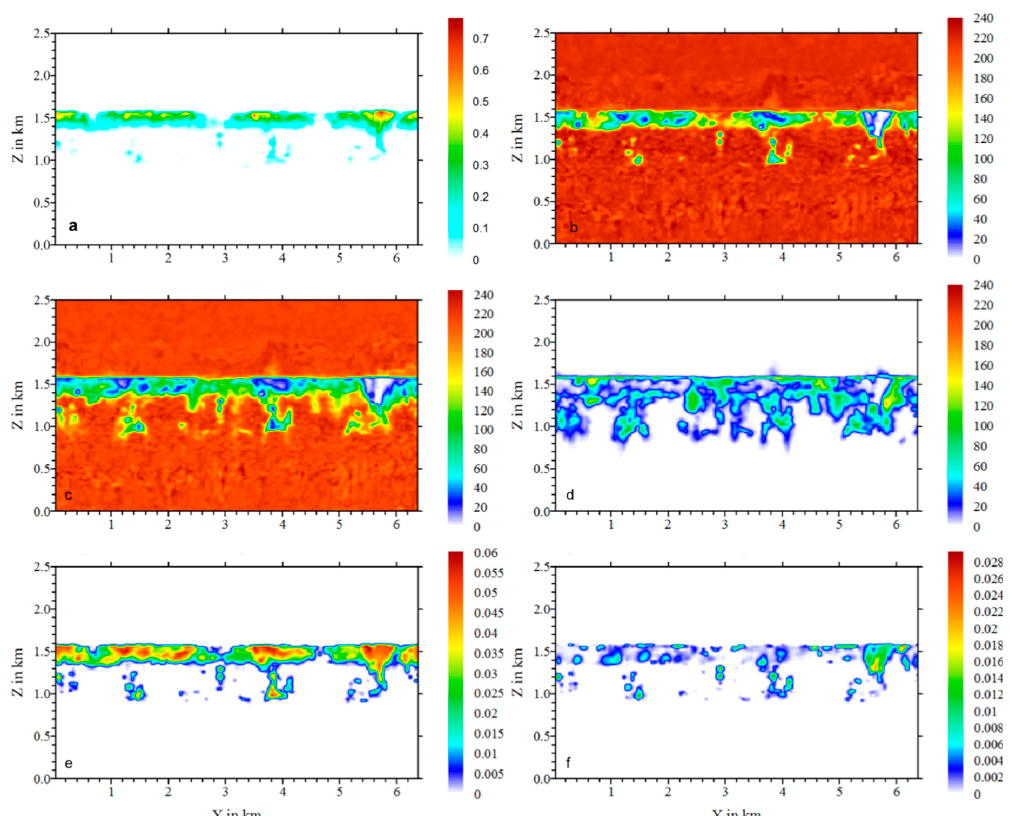
Figure 5. Vertical cross section of ( a ) the liquid water content (g cm − 3 ), ( b ) the number of aerosol particles (cm − 3 ), ( c ) the number of “pristine” aerosol particles (cm − 3 ), ( d ) the number of “processed” aerosol particles (cm − 3 ), ( e ) the “pristine” aerosol particle mass in drops (µg m − 3 ) and ( f ) the “processed” aerosol particle mass in drops (µg m − 3 ) after 205 min along the cross section indicated in Figure 3a and projected onto the Y-axis.